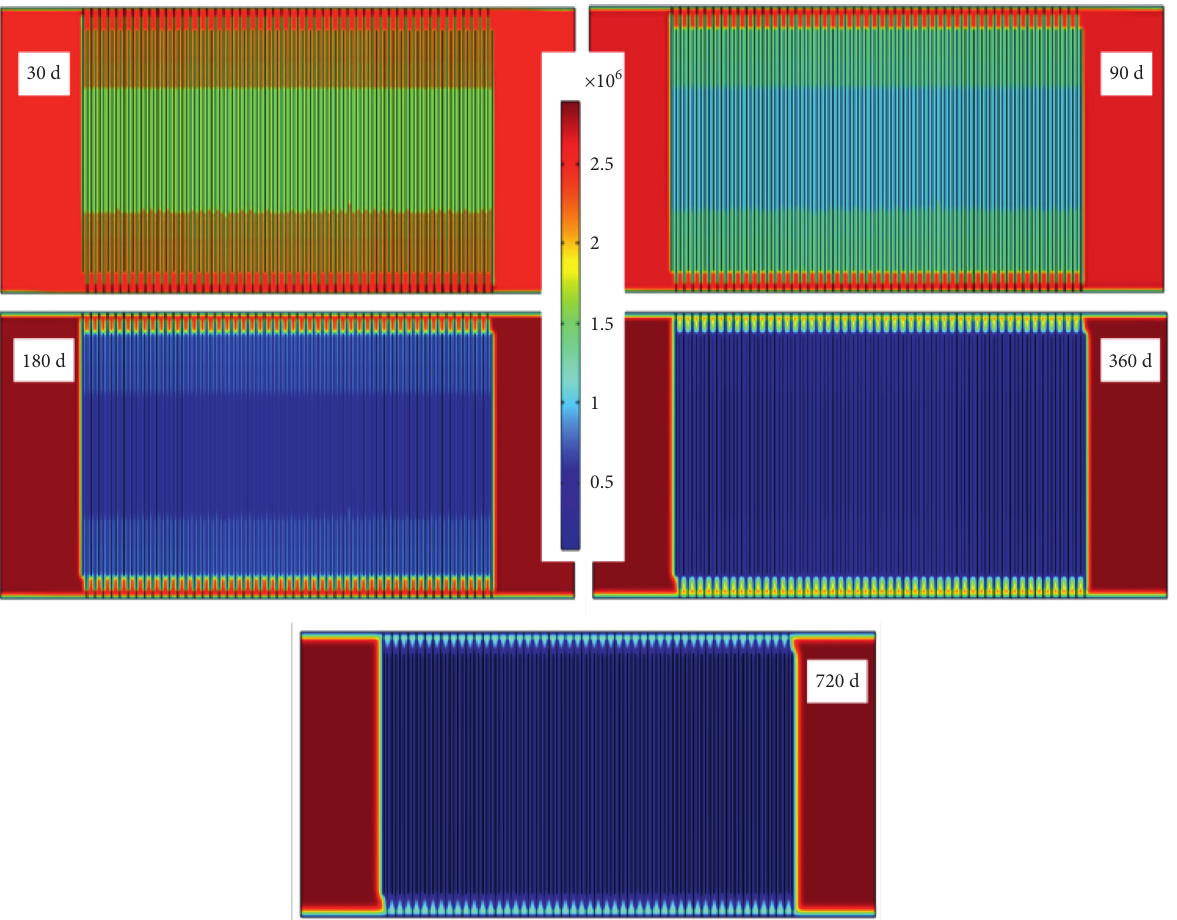
Figure 3: Gas pressure under different extraction